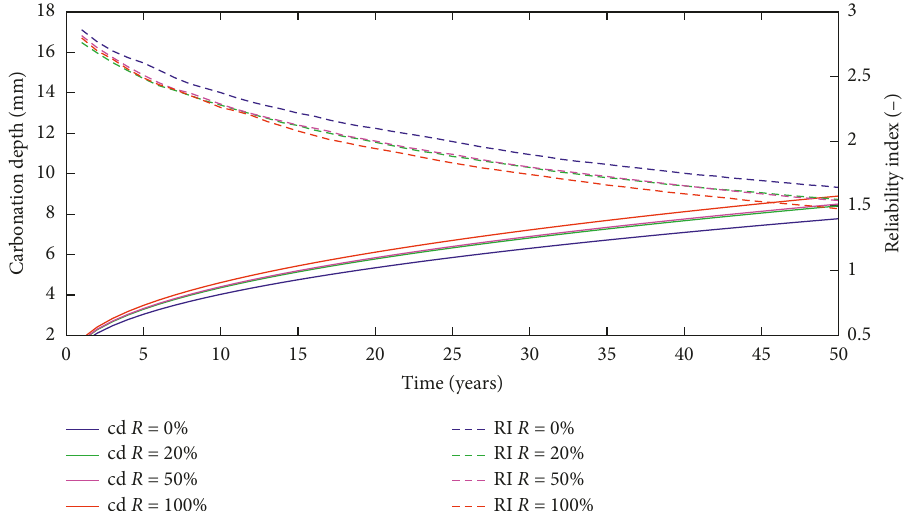
Figure 4: Carbonation depth (continuous line) and reliability index (dashed line) versus service life-XC4 exposure class: w/c �